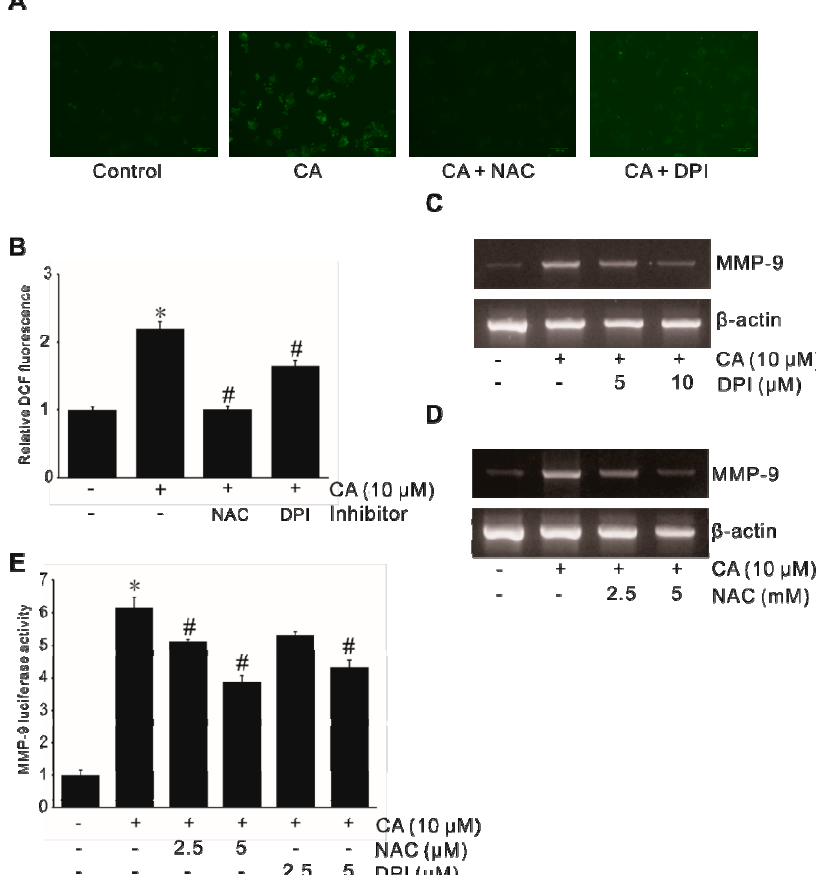
Figure 2. Activation of NADPH-oxidase-derived reactive oxygen species (ROS) during CA-induced MMP-9 expression in colon cancer cells. SW620 cells pretreated with diphenyleneiodonium chloride (DPI) or N-acetyl-L-cysteine (NAC) for 1 h were incubated with 10 μ M CA for 10 min. ( A ) Cells were then treated with 5 μ g/mL of 5- and 6-carboxyl 2 ′ ,7 ′ -dichlorodihydro-fluorescein diacetate (DCFDA) in the dark for 10 min. DCF fluorescence was imaged with a confocal laser scanning fluorescence microscope. ( B ) Statistically significant values of ROS production. Data represent the mean ± standard deviation (SD) from triplicate measurements. * p < 0.05 versus control; # p < 0.05 versus CA only. SW620 cells pretreated with DPI ( C ) or NAC ( D ) for 1 h were incubated with 10 μ M CA for 6 h, followed by mRNA extraction and RT-PCR to determine MMP-9 expression. ( E ) SW620 cells were transiently transfected with 500 ng pGL4-MMP-9 promoter–reporter construct. These transfected cells were pretreated with DPI or NAC for 1 h and then incubated with 10 μ M CA for 4 h. The luciferase activity was then determined using a luminometer. Data represent the mean ± standard deviation (SD) from triplicate measurements. * p < 0.05 versus control; # p < 0.05 versus CA only.